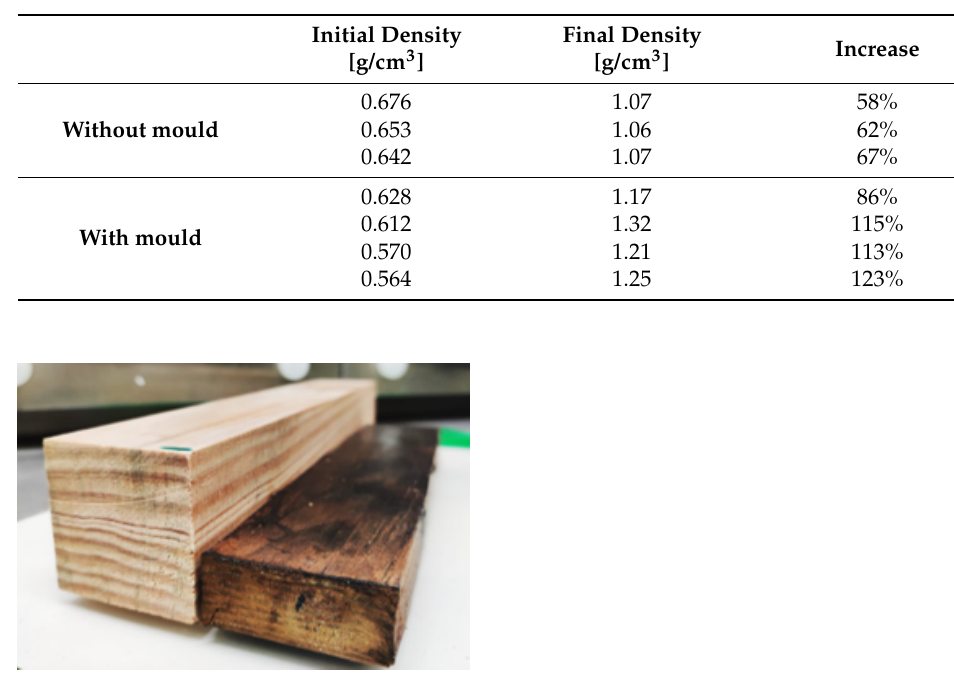
Figure 7. Visual comparison between a natural block and a densified block (with